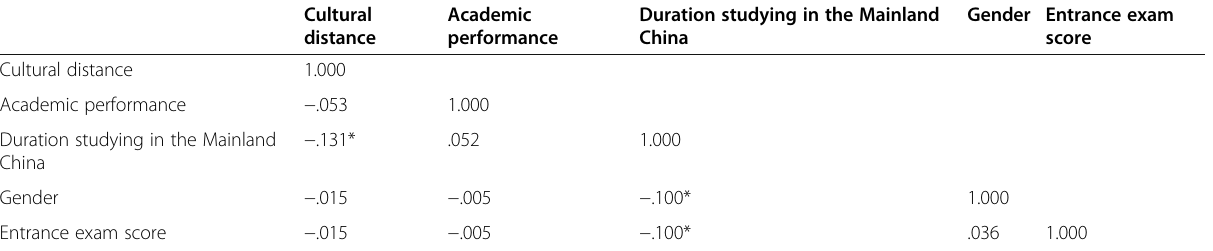
Table 2 Correlations among main variables